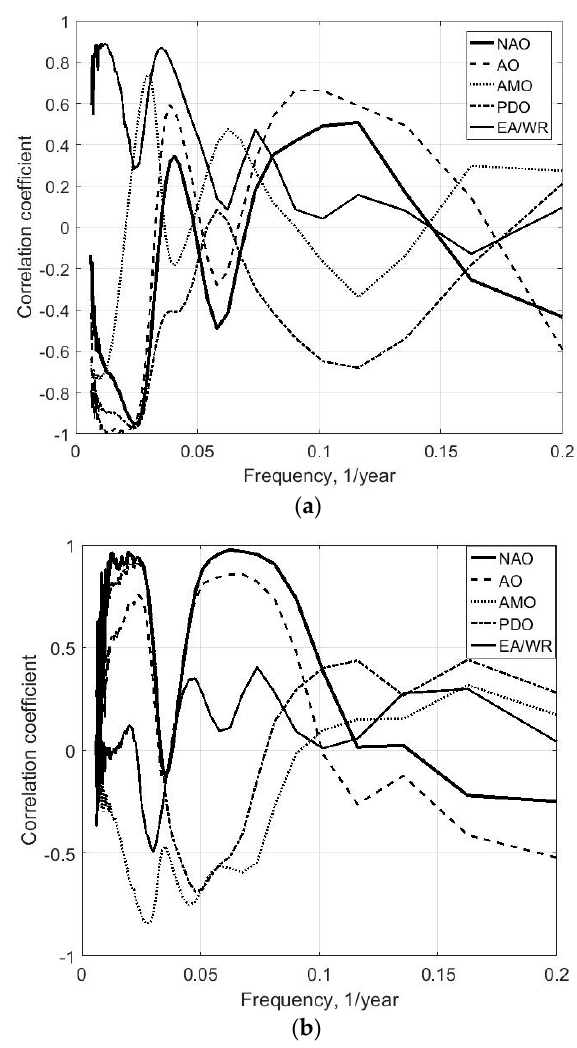
Figure 7. Coefficients of wavelet-correlation functions between climatic indices and average annual wave periods ( a ) and heights ( b ) at zero time lags.